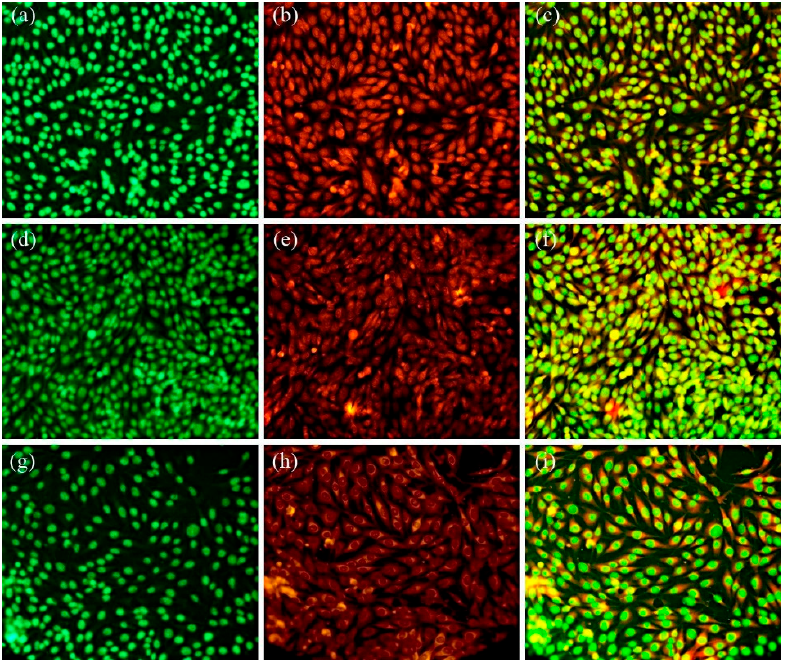
Figure 10. The morphology of MG63 (ATCC CRL1427) cells grown onto HAp ( a – c ), 0.05 AgHAp ( d – f ), and 0.1 AgHAp ( g – i ) (red filter—mitotracker red staining, green filter—acridine orange, 200×).